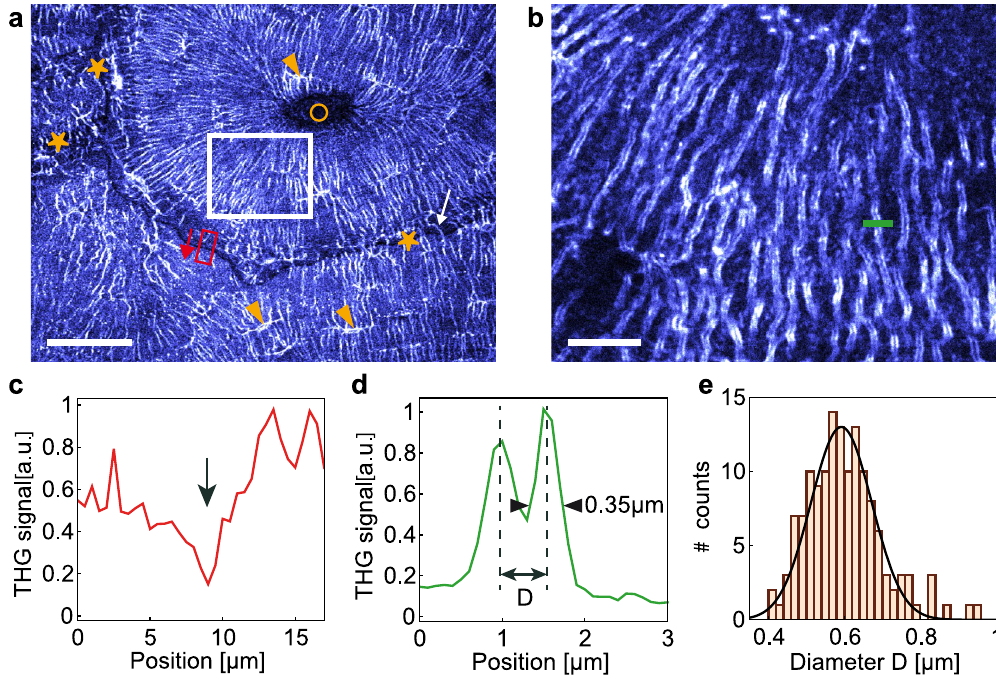
Figure 2. THG reveals interfaces in cortical bone. ( a ) THG image of a transverse section of a bovine femur at a depth of 10 µ m within the sample, revealing the LCN (lacunae indicated with arrowheads) and the cement line of the osteons (stars). Circle, Haversian channel. The white arrow shows a canalicule crossing the cement line. Scale bar, 50 µ m. ( b ) Zoom on the white box shown in ( a ), revealing the two interfaces of the canaliculi. Scale bar, 10 µ m. ( c ) Profile along the red box in ( a ), illustrating the reduced signal at the cement line (arrow). ( d ) Profile across a canalicule along the green line in b providing an estimate for the canalicule diameter D and for the lateral resolution. ( e ) Distribution of canalicule diameters D estimated from THG images in the volume shown in Supplementary Movie 1 including image ( b